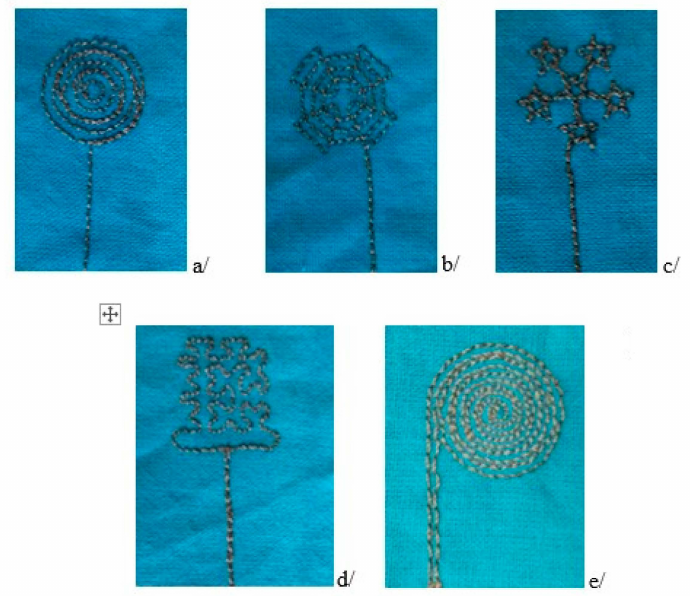
Figure 8. Embroidered textile sensors: ( a ) concentric circles; ( b ) cobweb; ( c ) five-pointed star; ( d ) Hilbert curve; ( e ) spiral.